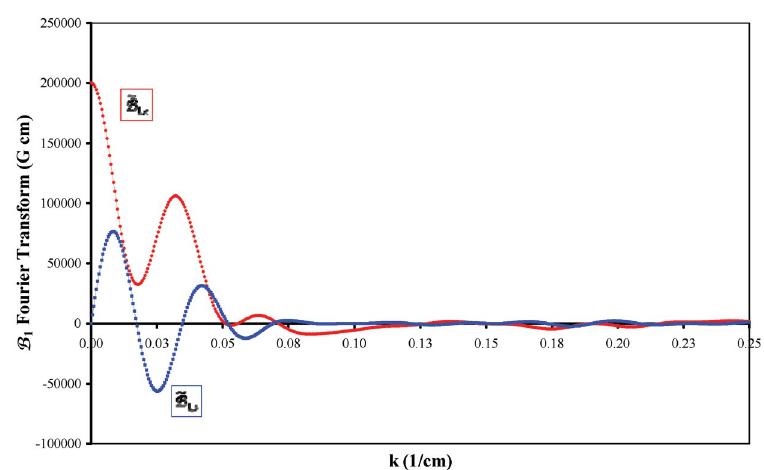
(cid:4) R; k (cid:5) versus k . 1 ;(cid:4)